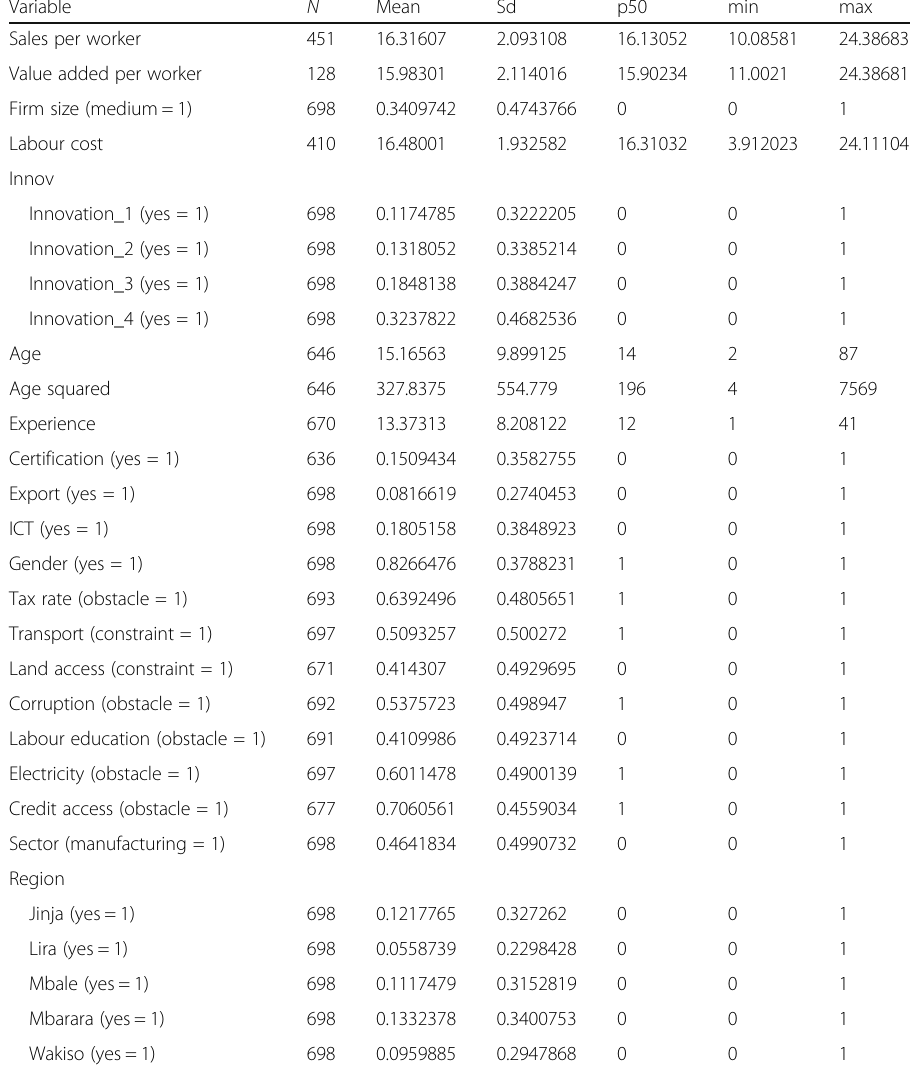
Table 1 Summary